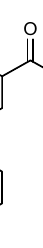
Figure 6. Biaryl glycosides have also been developed as antagonists of the adhesin FmlH; co-treatment with FmlH and FimH antagonists in a mouse model of urinary tract infection significantly facilitated bacterial clearance [31].